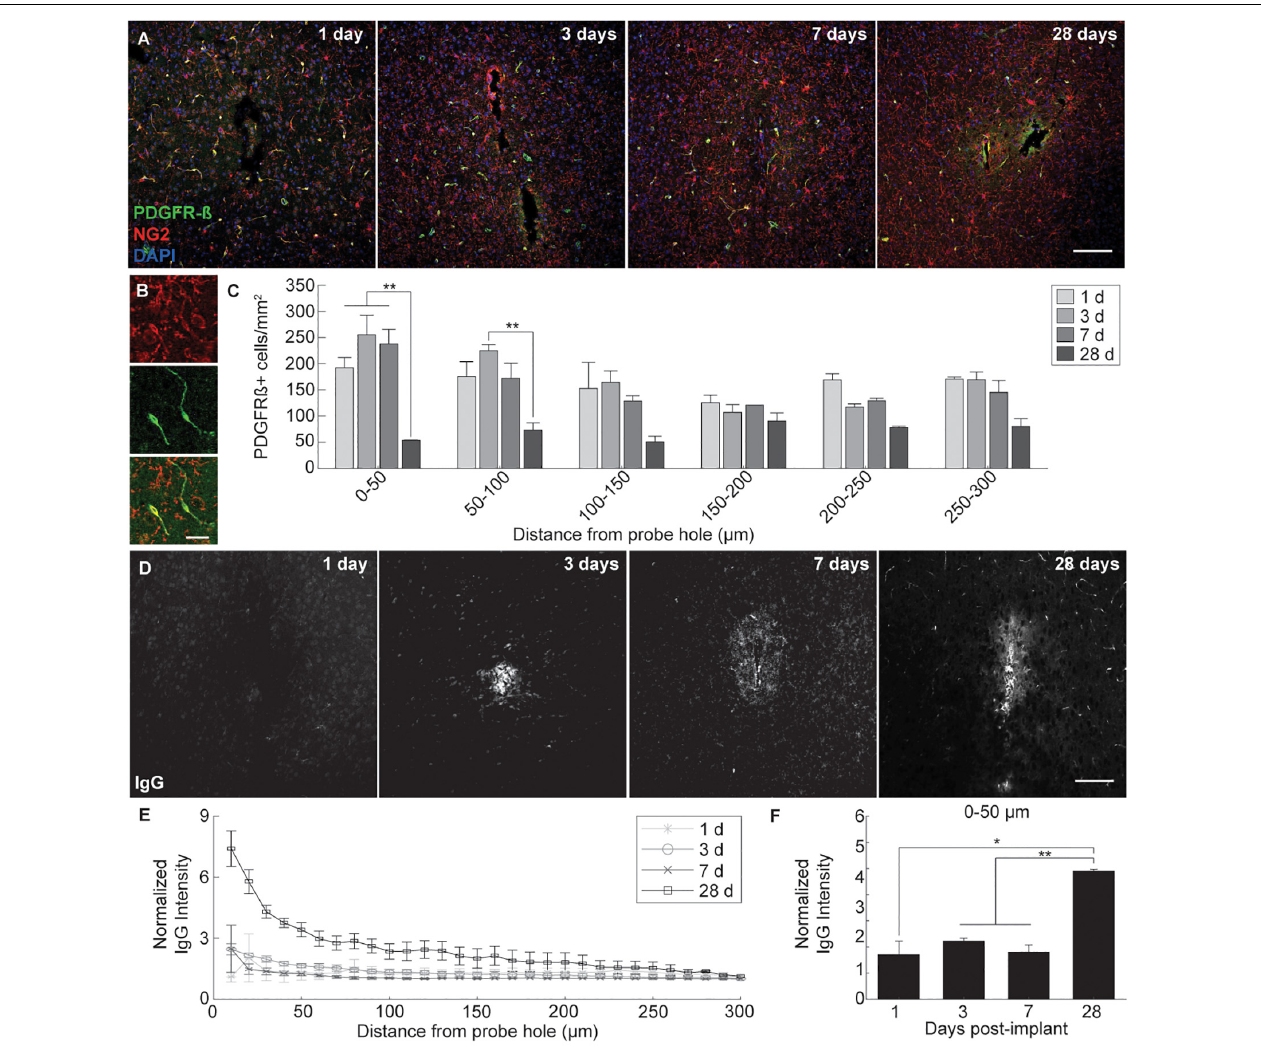
FIGURE 6 | Pericyte dysregulation and blood-brain barrier disruption around an implanted microelectrode array. Microelectrode implantation induces pericyte reactivity and increased BBB leakage within close proximity to the electrode interface, suggesting a progressive dysregulation of the neurovascular unit following injury. (A) BBB-associated pericytes were visualized around implanted devices by representative immunohistochemical stains for PDGFR- β (green), NG2 (red), and cell nuclei (blue) at 1, 3, 7, and 28 days post-insertion. Scale bar = 100 µ m. (B) Magnified images of NG2+ (top), PDGFR- β + (middle), and NG2+PDGFR- β + cells (bottom). Scale bar = 20 µ m. (C) Spatiotemporal patterns of PDGFR- β + cell density within 50 µ m bins up to 300 µ m away from the probe hole. (D) Temporal patterns of device-induced bleeding revealed by representative immunohistochemical stains for immunoglobulin G at 1, 3, 7, and 28 days post-insertion. (E) Normalized IgG intensity within 10 µ m bins up to 300 µ m away from the probe hole. (F) Normalized IgG intensity averaged over the first 50 µ m from the probe hole. Increased IgG expression around the probe hole coincides with reduced pericyte densities at 28 days post-insertion. ∗ indicates p < 0.05. ∗∗ indicates p <